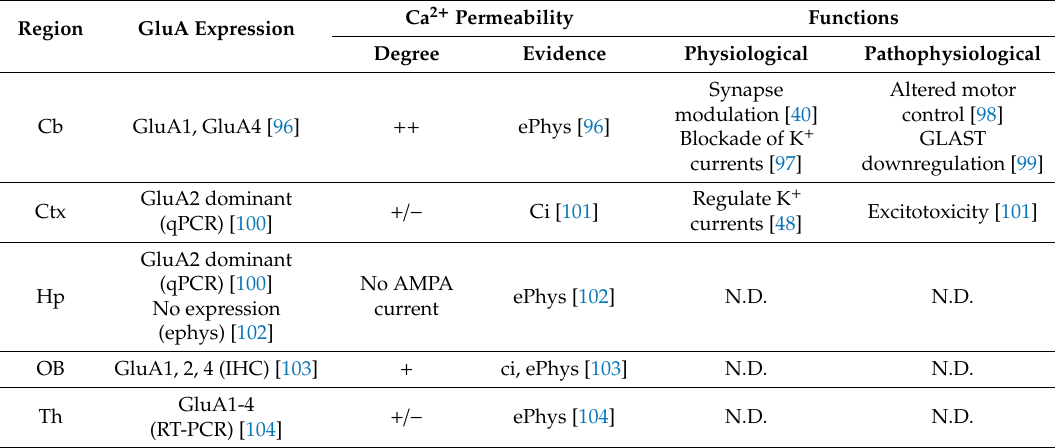
Table 1. Summary of AMPAR expression and functions in